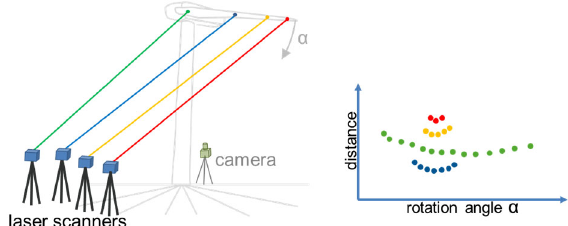
Figure 2. Recording of profile data with distance measuring devices depending on the angle of rotation α from 3